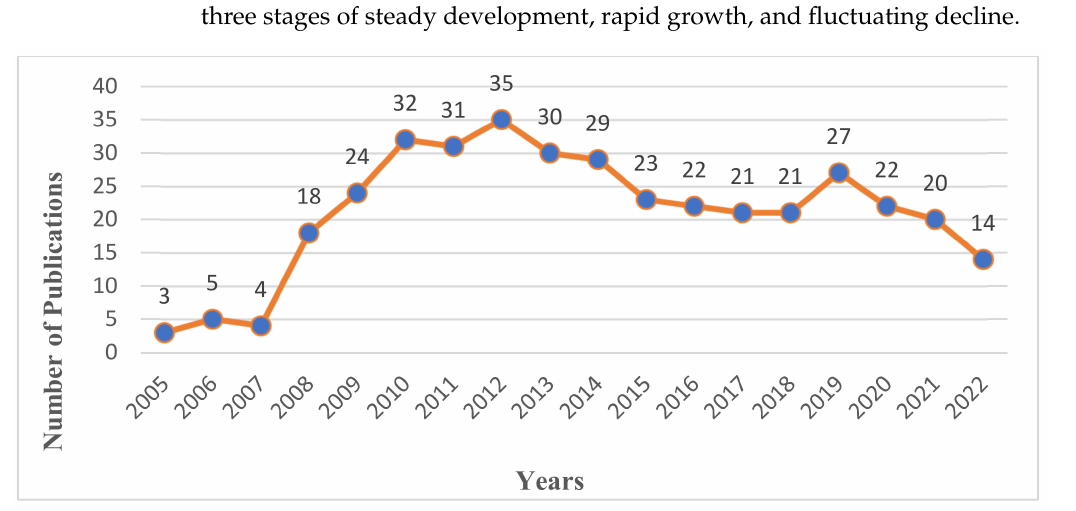
Figure 1. The number of ICH publications in Chinese journals from 2005 to 2022.